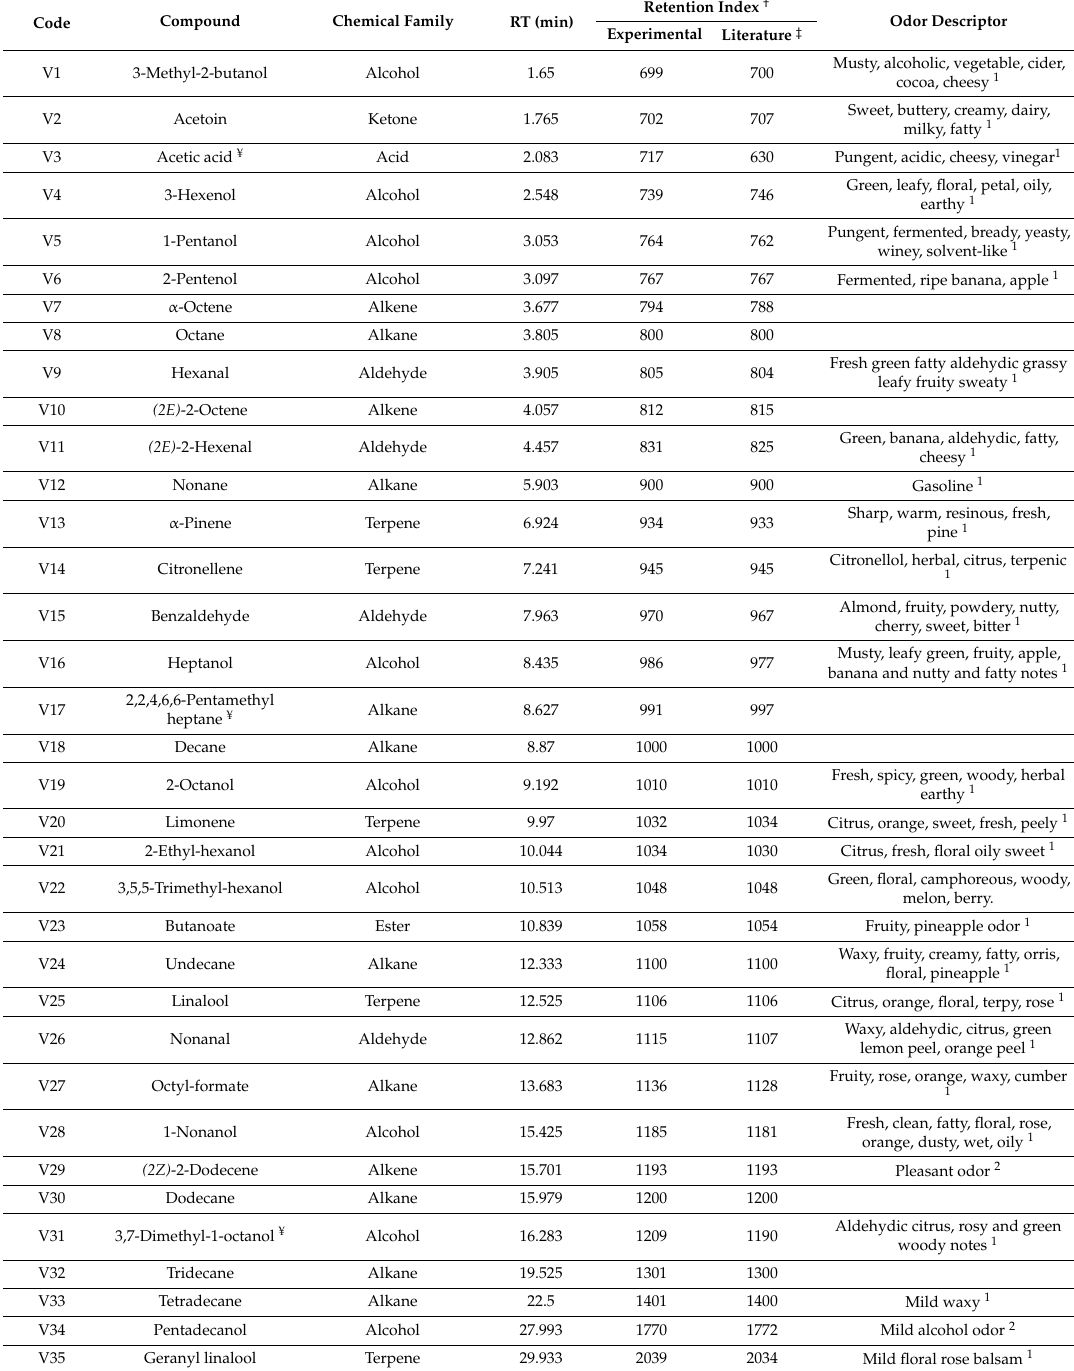
Table 5. Volatile compounds profile in raw studied almonds cultivars, retention index and main odor and aroma